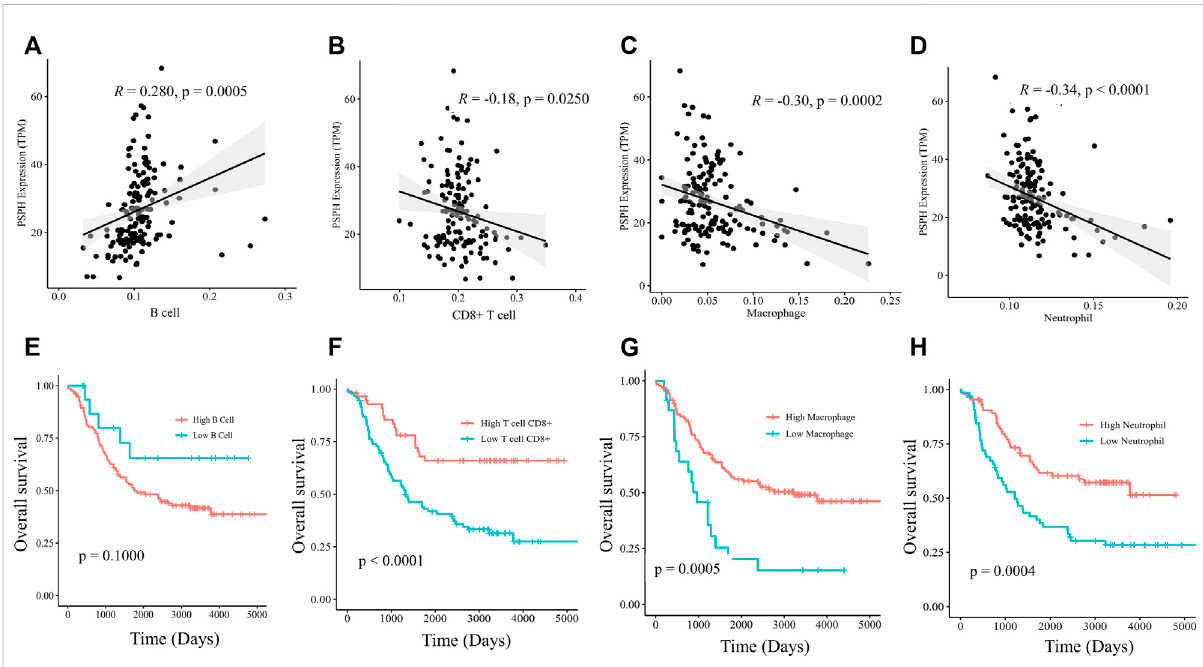
FIGURE 5 ScatterplotsofBcell (A) ,CD8 + Tcell (B) ,macrophages (C) ,neutrophils (D)